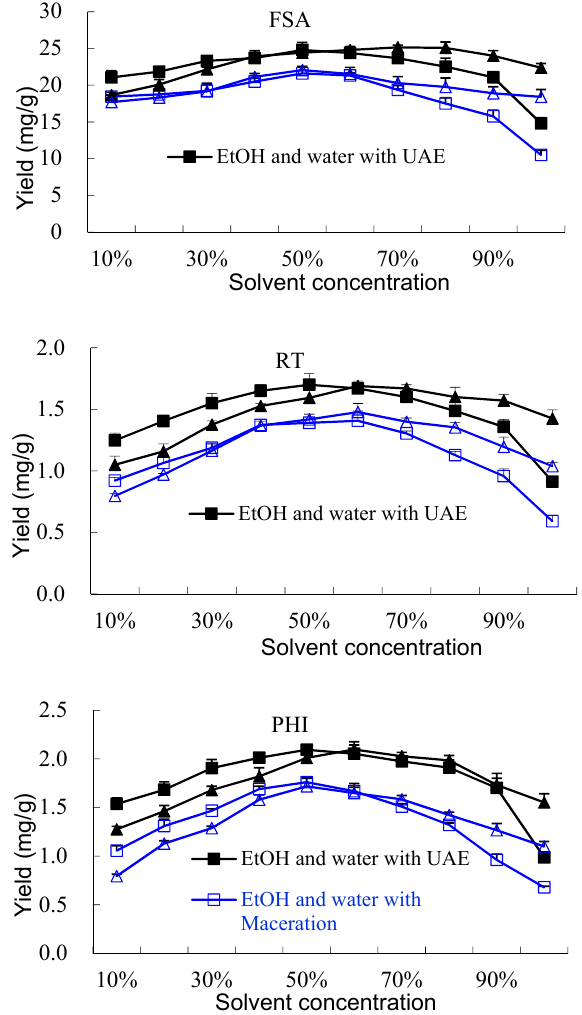
Figure 2. Effect of different solvents on the extraction yields of forsythiaside A (FSA), rutin (RT) and phillyrin (PHI). UAE, ultrasonic-assisted extraction.